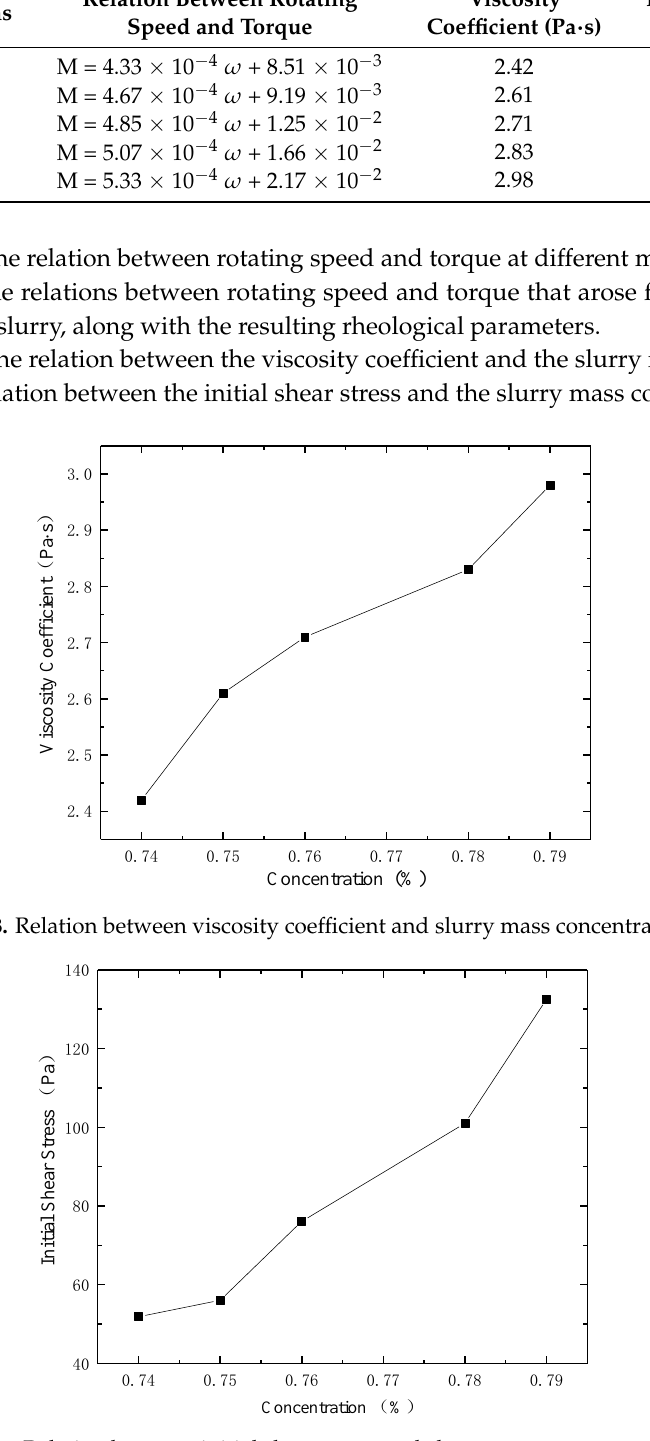
Table 9. Relation between rotating speed and torque and the rheological parameters at different concentrations of the slurry.